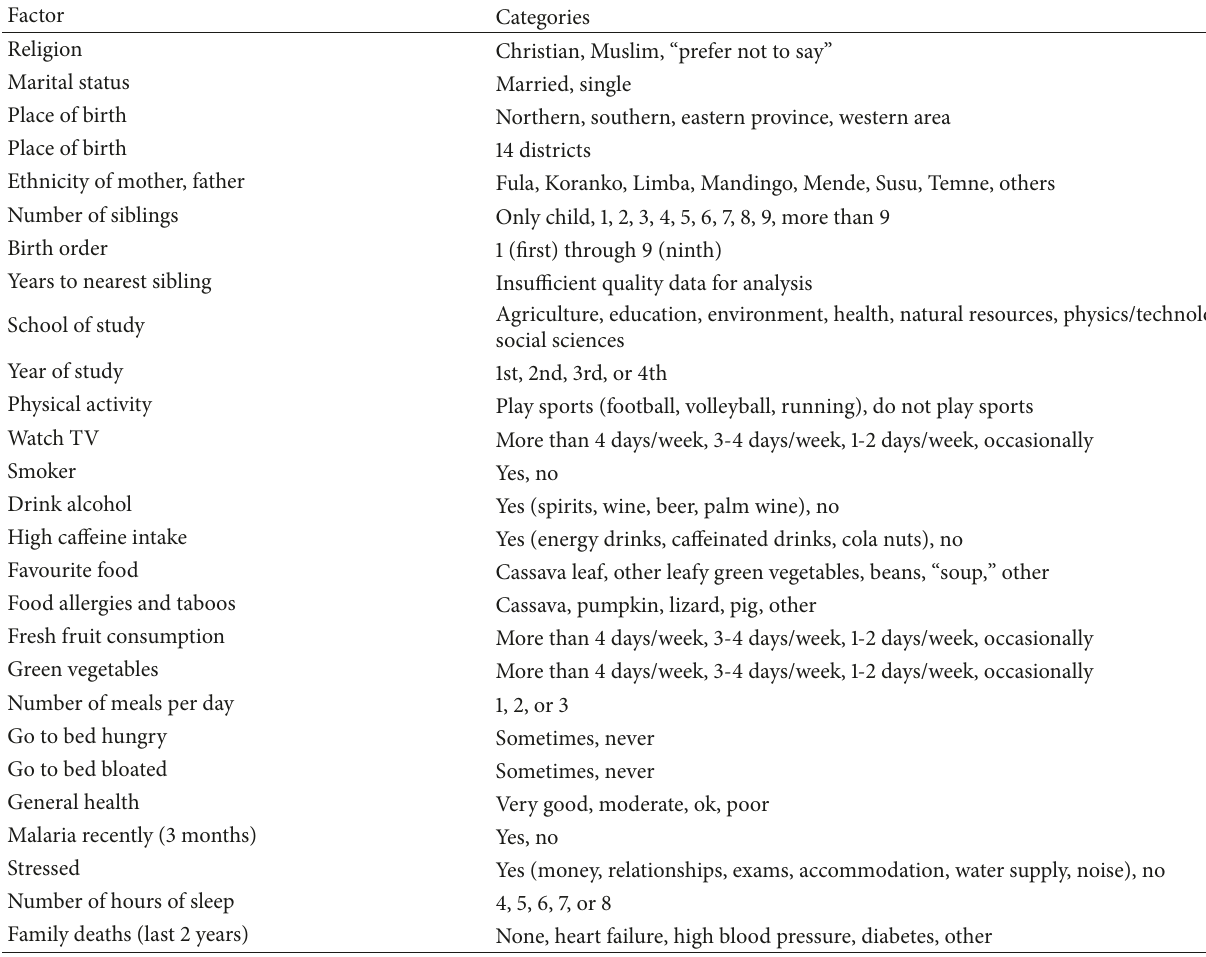
Table 3: Risk Factors with no conventionally statistically significant relations to blood pressure in our